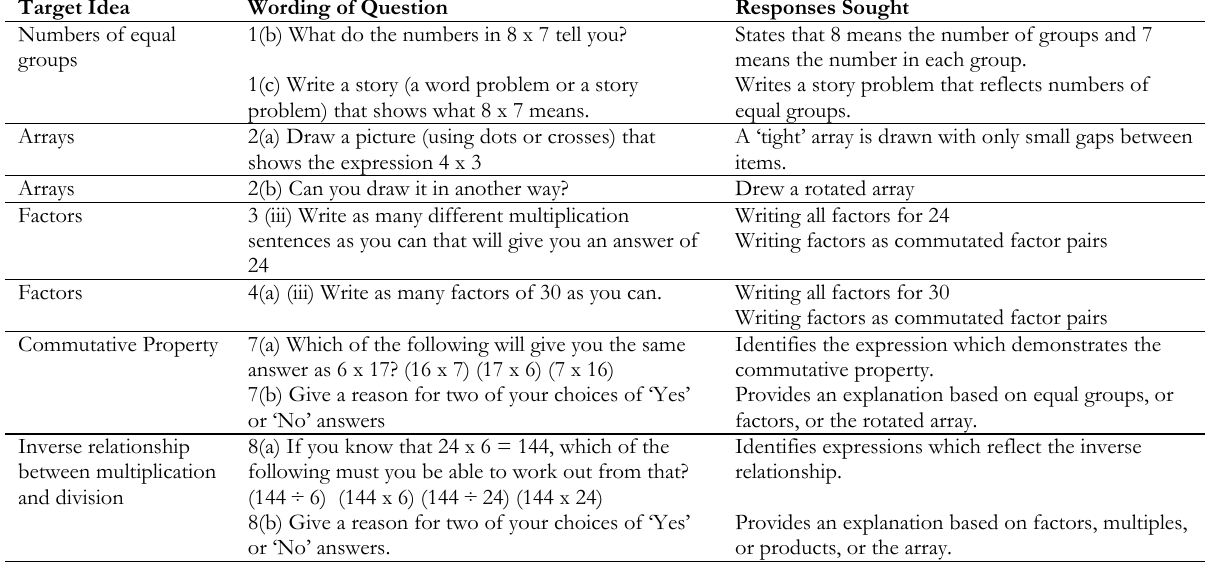
Figure 1. Conceptual Framework Table 1. MTQ questions related to the conceptual